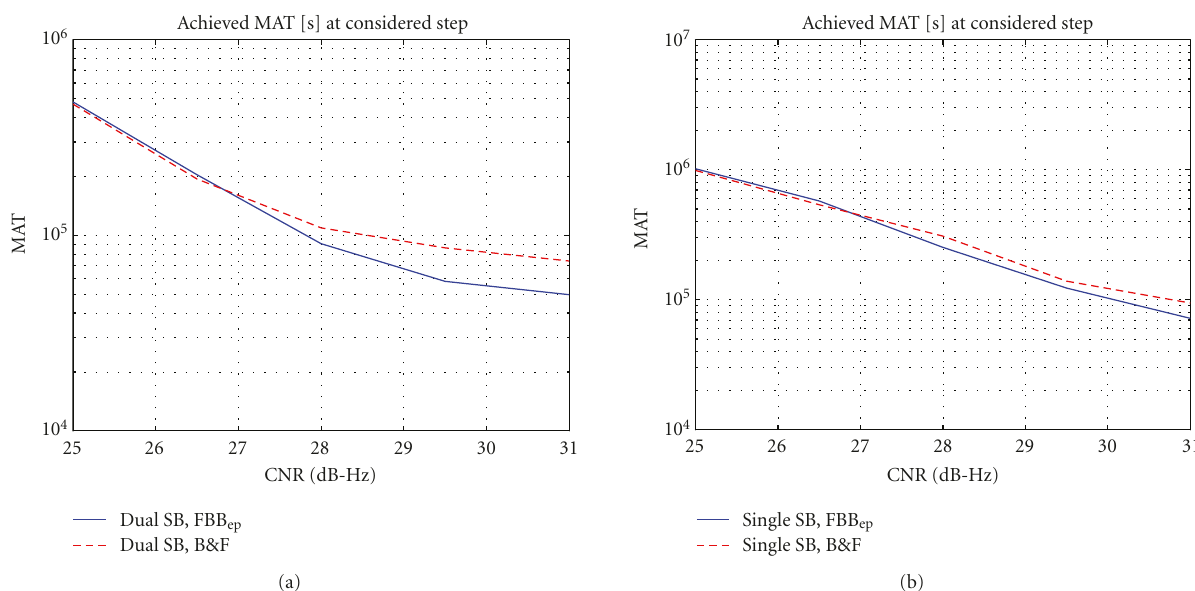
Figure 10: Mean acquisition time corresponding to the step needed to achieve a target average P d = 0 . 9, at false alarm P fa = 10 − 3 , Sin- BOC(1,1) signal. Code length 4092 chips, penalty factor K penalty = 10 6 , single frequency-bin. N pieces = 2 for FBB ep . Left: dual sideband. Right: single sideband.